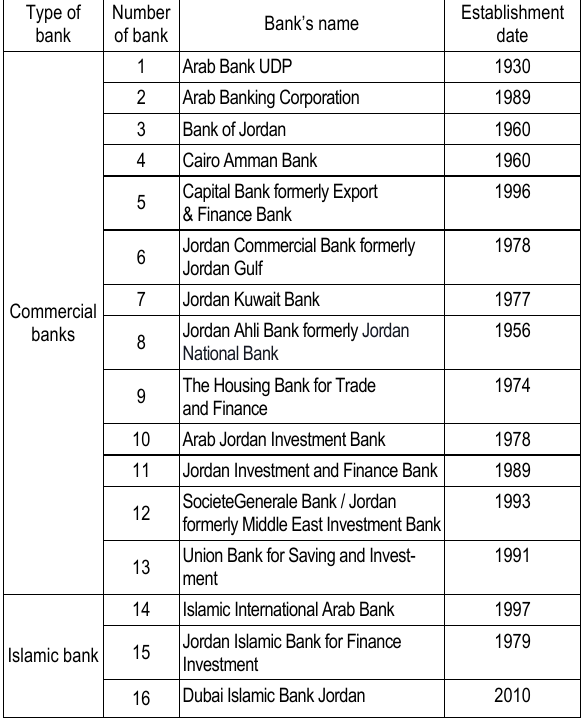
Table 2. List of banks in study